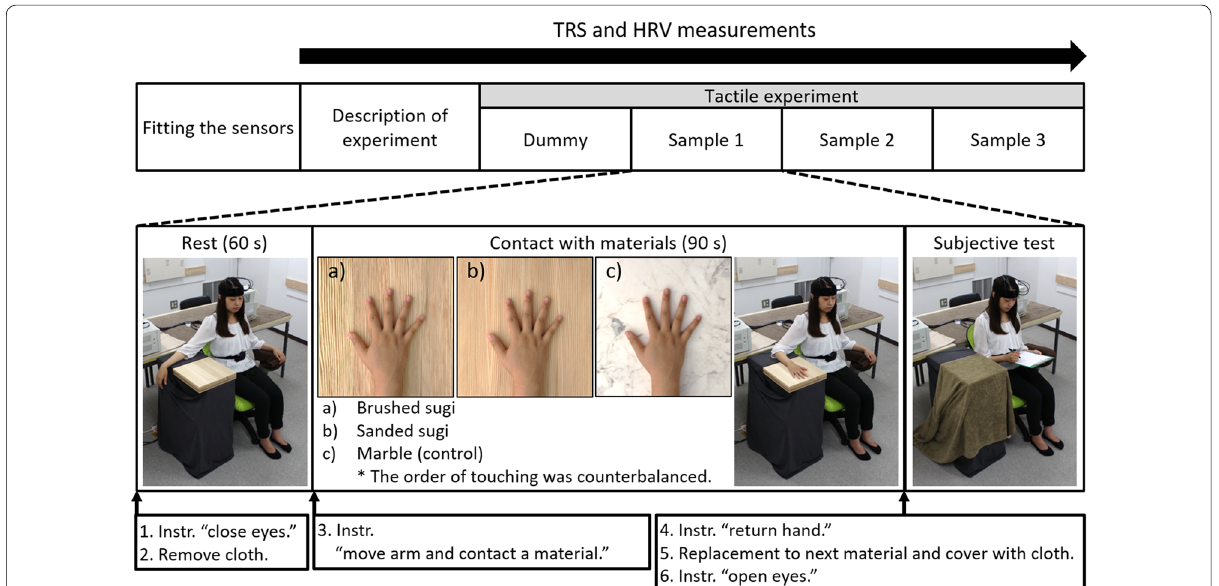
Fig. 1 Experimental procedure. TRS near-infrared time-resolved spectroscopy, HRV heart rate variability, Instr. instruction to the